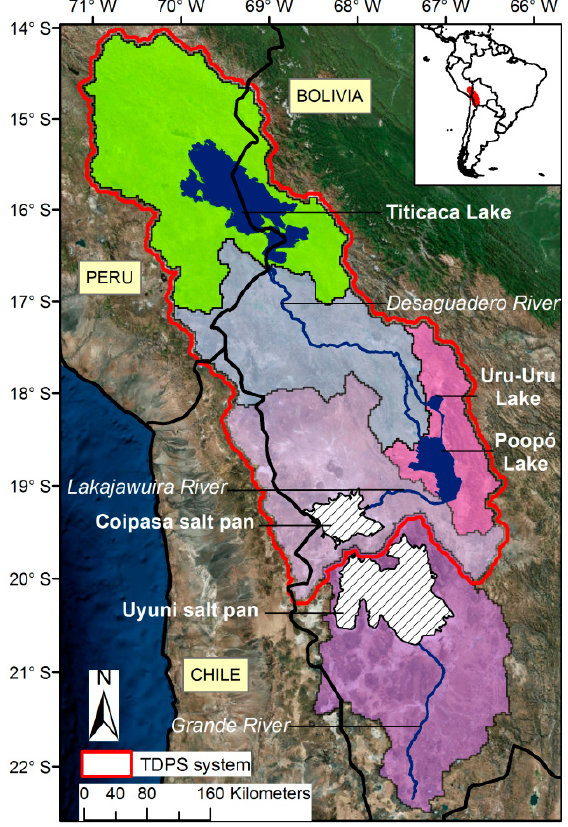
Figure 1. Location of Titicaca Lake in the study area.